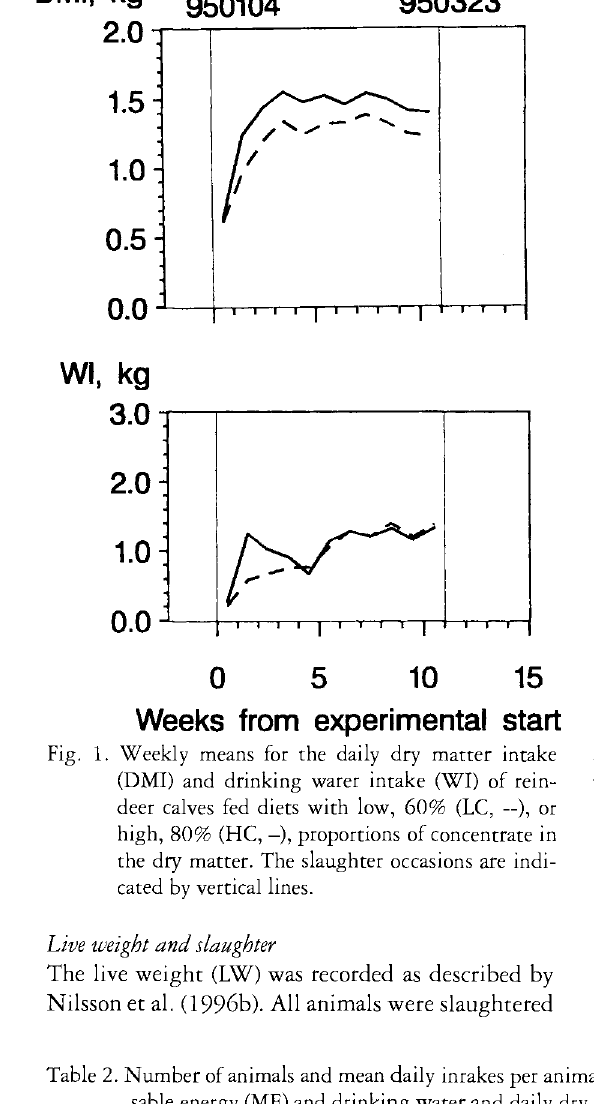
The live weight (LW) was recorded as described by